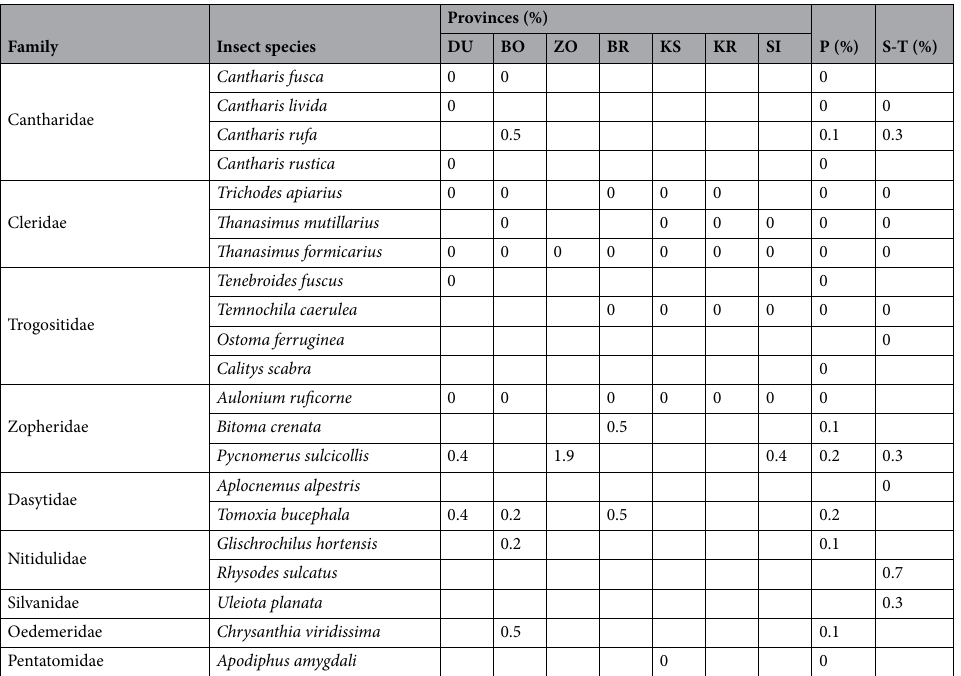
Table 3. Bevan damage indices of identified insect species. P, Pheromone traps, S-T, Trapped on stored logs and wood.